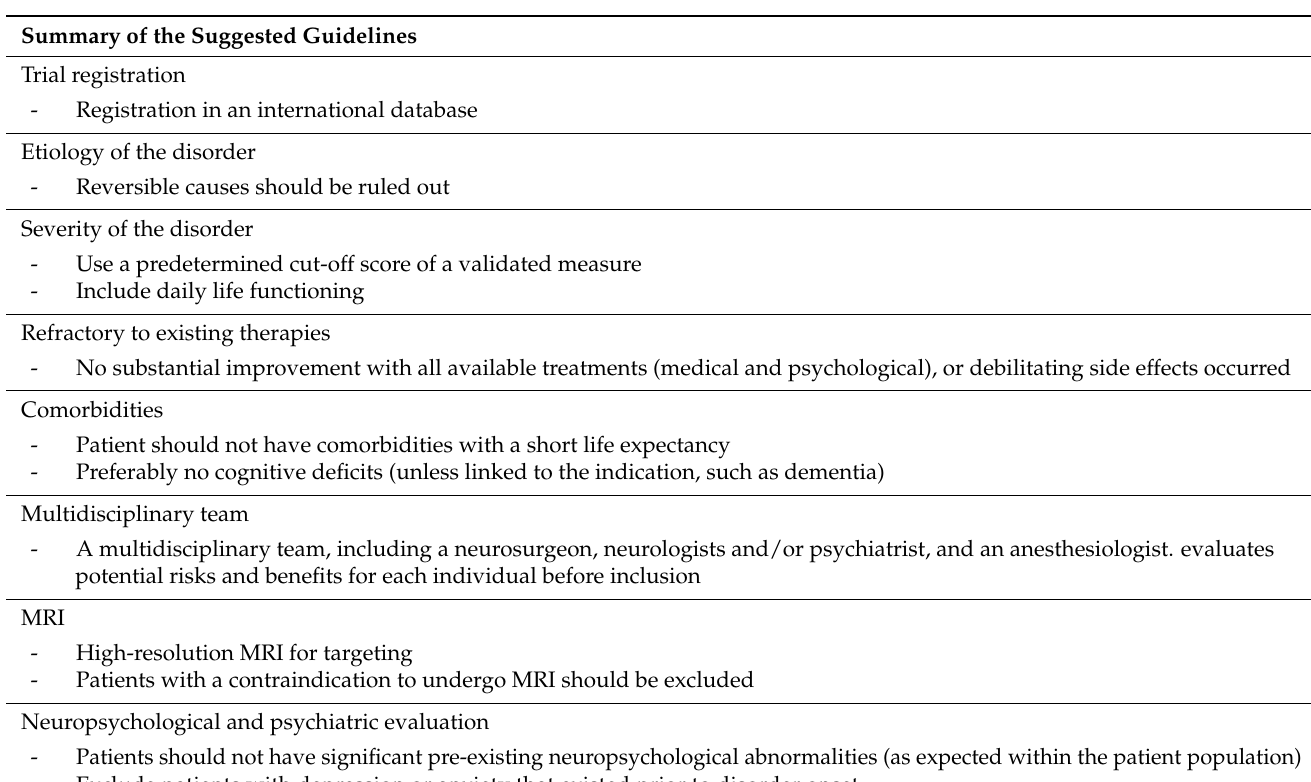
Table 3. Summary of the advised guidelines for patient selection and